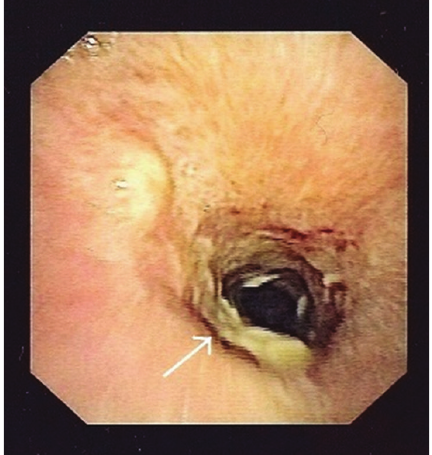
Figure 2: Bronchoscopy revealing extended white mucus coverings causative of the tracheal stenosis.